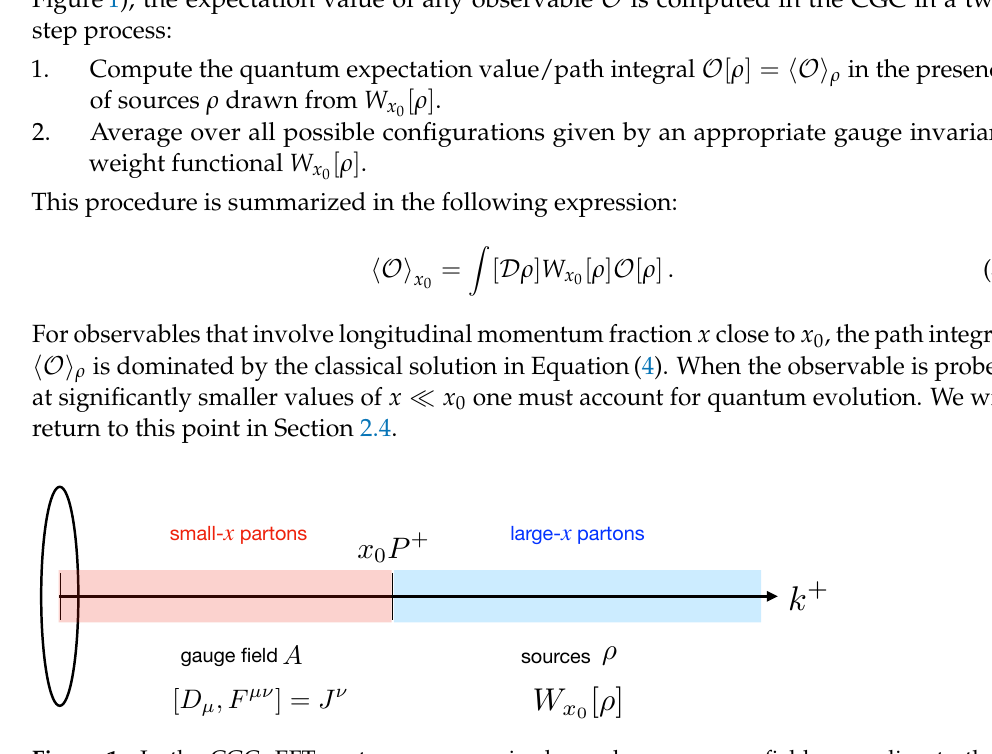
Figure 1. In the CGC, EFT partons are organized as color sources or fields according to their longitudinal momentum fraction x relative to the characteristic momentum fraction of the probe x 0 . Sources are stochastic and their distribution is characterized by a gauge invariant weight functional [ ρ ] (represented in blue). The gauge field is a solution to Yang–Mills equations in the presence of W x 0 the sources (represented in